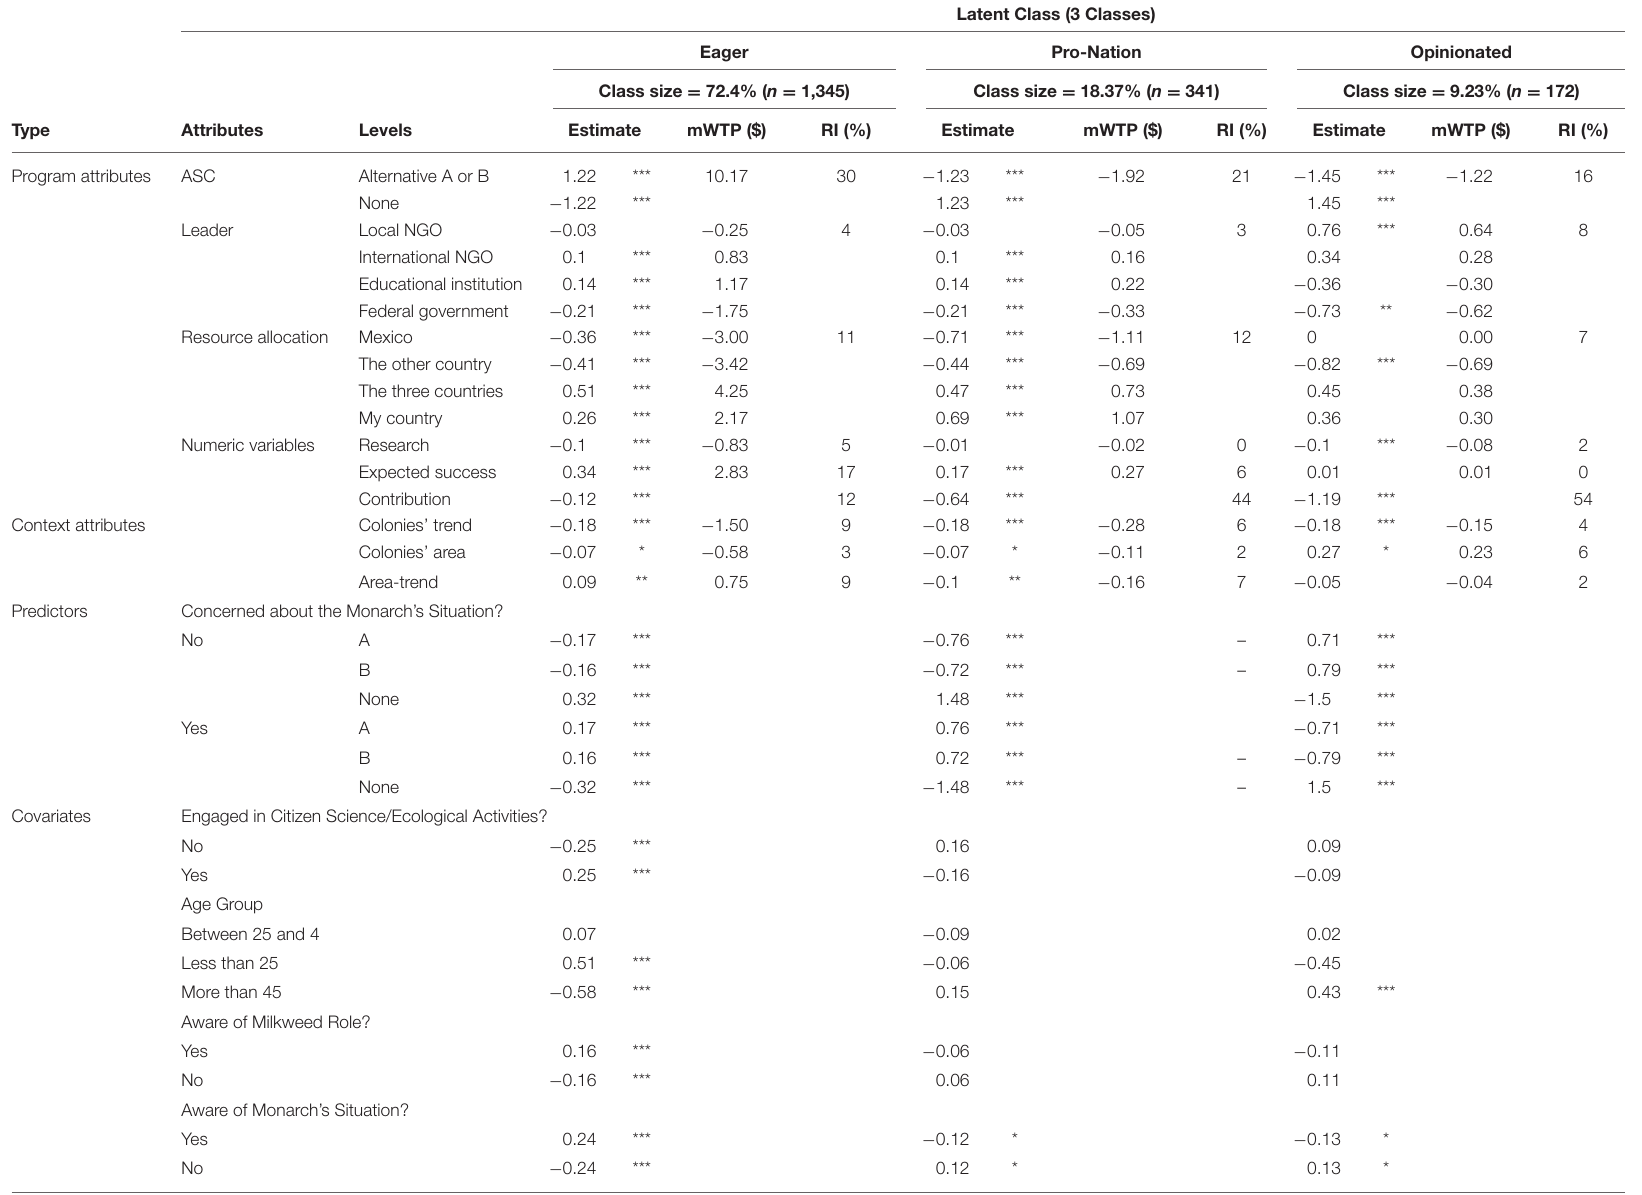
TABLE 6 | Latent class (3 classes) estimates and Marginal Willingness to Pay (mWTP) for the main urban residents’